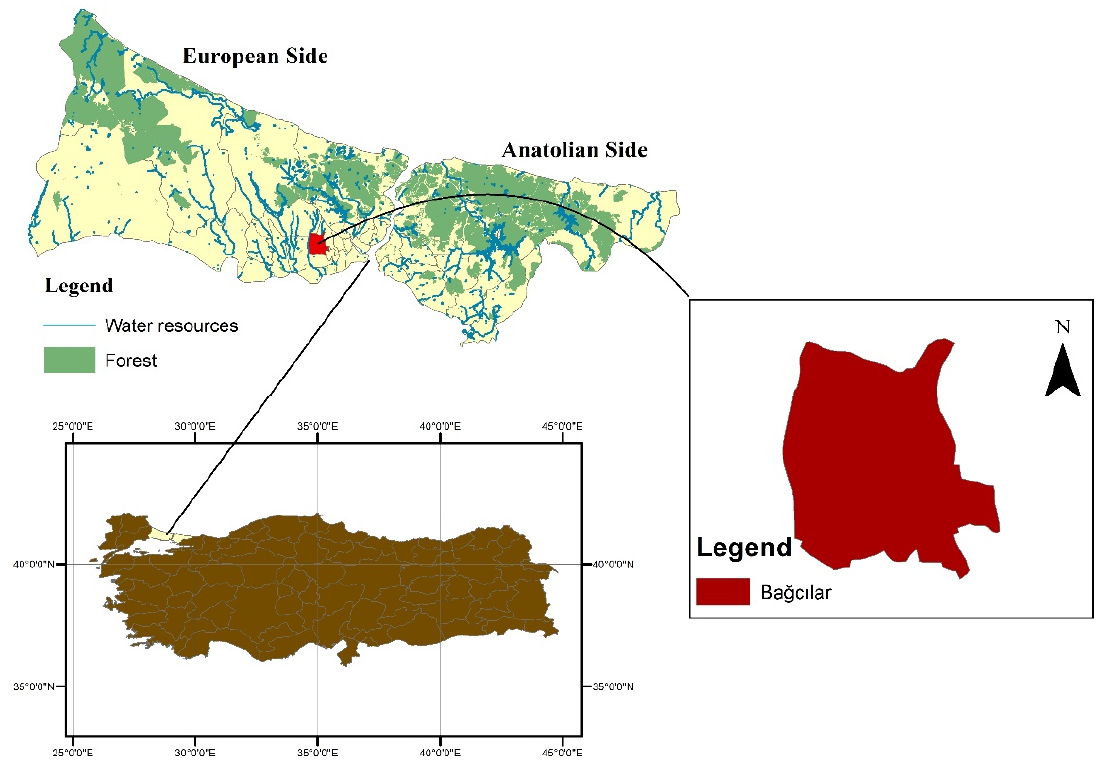
Figure 3. Study Figure 3. Study area.